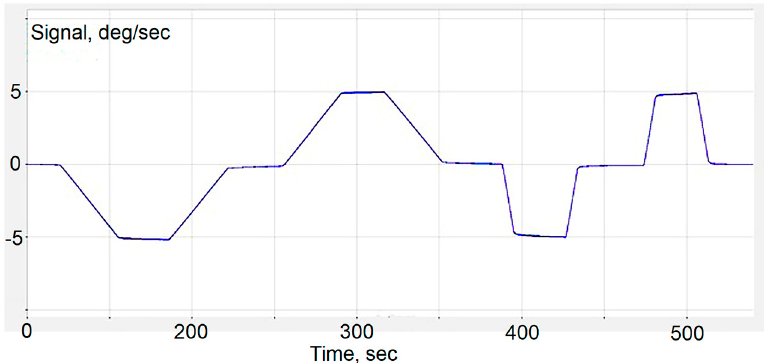
Figure A1. Signal of molecular–electronic angular accelerometer with negative MHD feedback for different rotation parameters. After that the signal was integrated. The integration result is shown in Figure A2. Sensors 2018 , 18 , 245